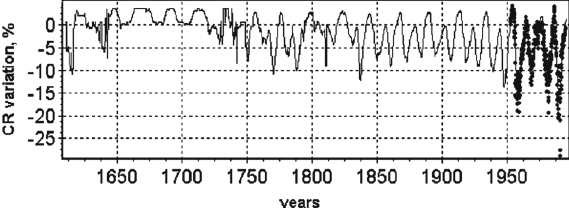
Fig.15 An unsuccessful attempt ofthe reconstructionofcosmic-ray intensity in thepast usinga regression with sunspot numbers. Dots represent the observed cosmic-ray intensity since 1951. Note the absence of a long-term trend. Image reproduced by permission from Belov et al. (2006), copyright by